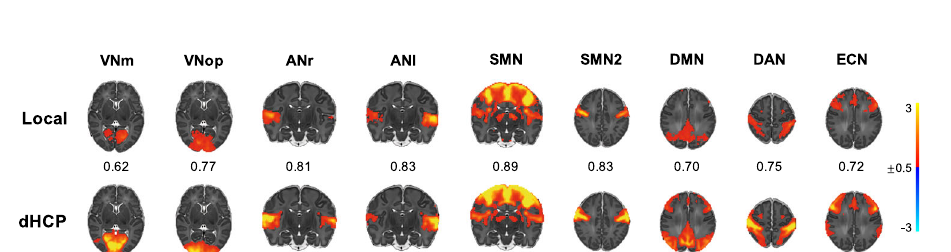
Fig. 3 Nine resting-state networks replicated across two independent datasets. Each resting-state network map is a thresholded group-level probabilistic functional mode (PFM) map identi fi ed in the locally collected noxious stimulation paradigm dataset ( n = 18 subjects ’ resting-state data) (top row, Local) and the age-matched dHCP dataset ( n = 242 subjects ’ resting-state data) (bottom row, dHCP). These PFM posterior probability maps are thresholded to highlight qualitative correspondence (means of posterior distributions are scaled according to colour bar). The scalar value shown between matched maps is the spatial Pearson correlation coef fi cient between unthresholded maps highlighting quantitative correspondence. VNm medial visual network, VNop occipital pole visual network, ANr right auditory network, ANl left auditory network, SMN somatomotor network, DMN default mode network, DAN dorsal attention network, ECN executive control network. Source data are provided as a Source Data fi le.